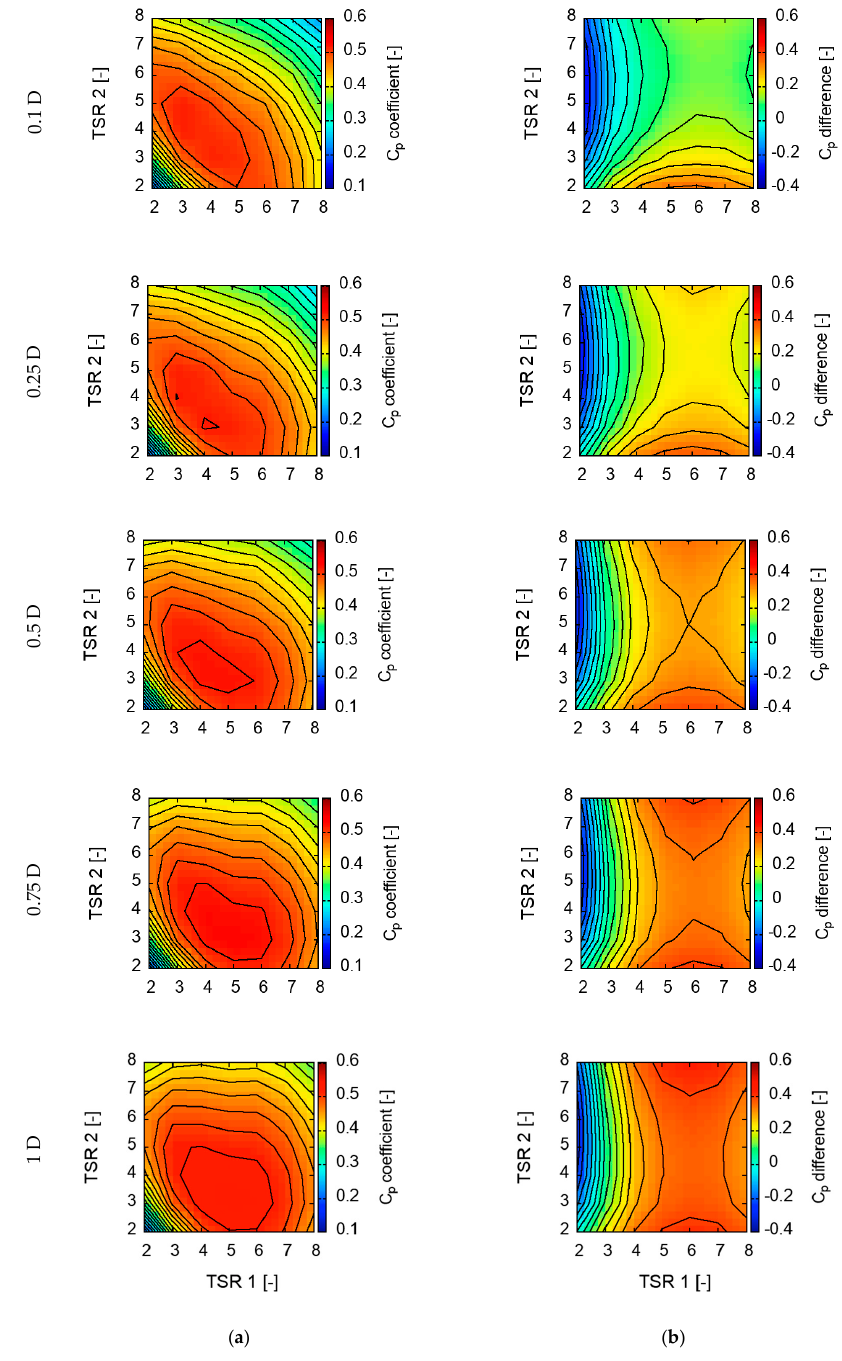
ffi cient C ff erence in C p ( a ) and the di p between rotors ( b